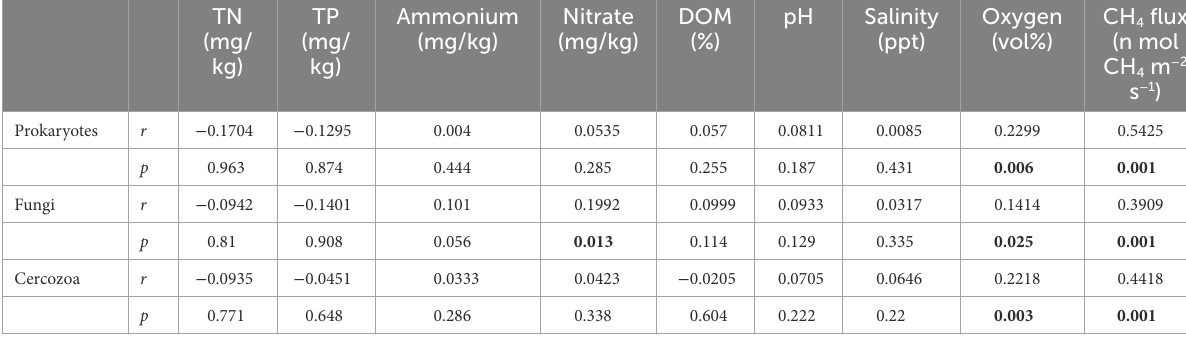
TABLE 1 Mantel tests for the correlation between environmental variables and community structure in prokaryotic, fungal, cercozoan communities based on Jaccard distance.